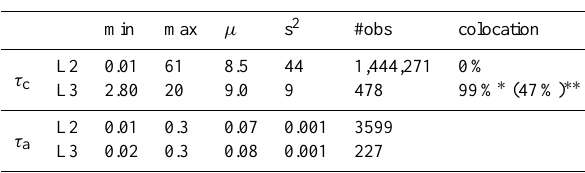
Table 2. Statistics for τ c and τ a MODIS L2 and L3 data for the region in Fig. 8 and the box and inset region in Fig.